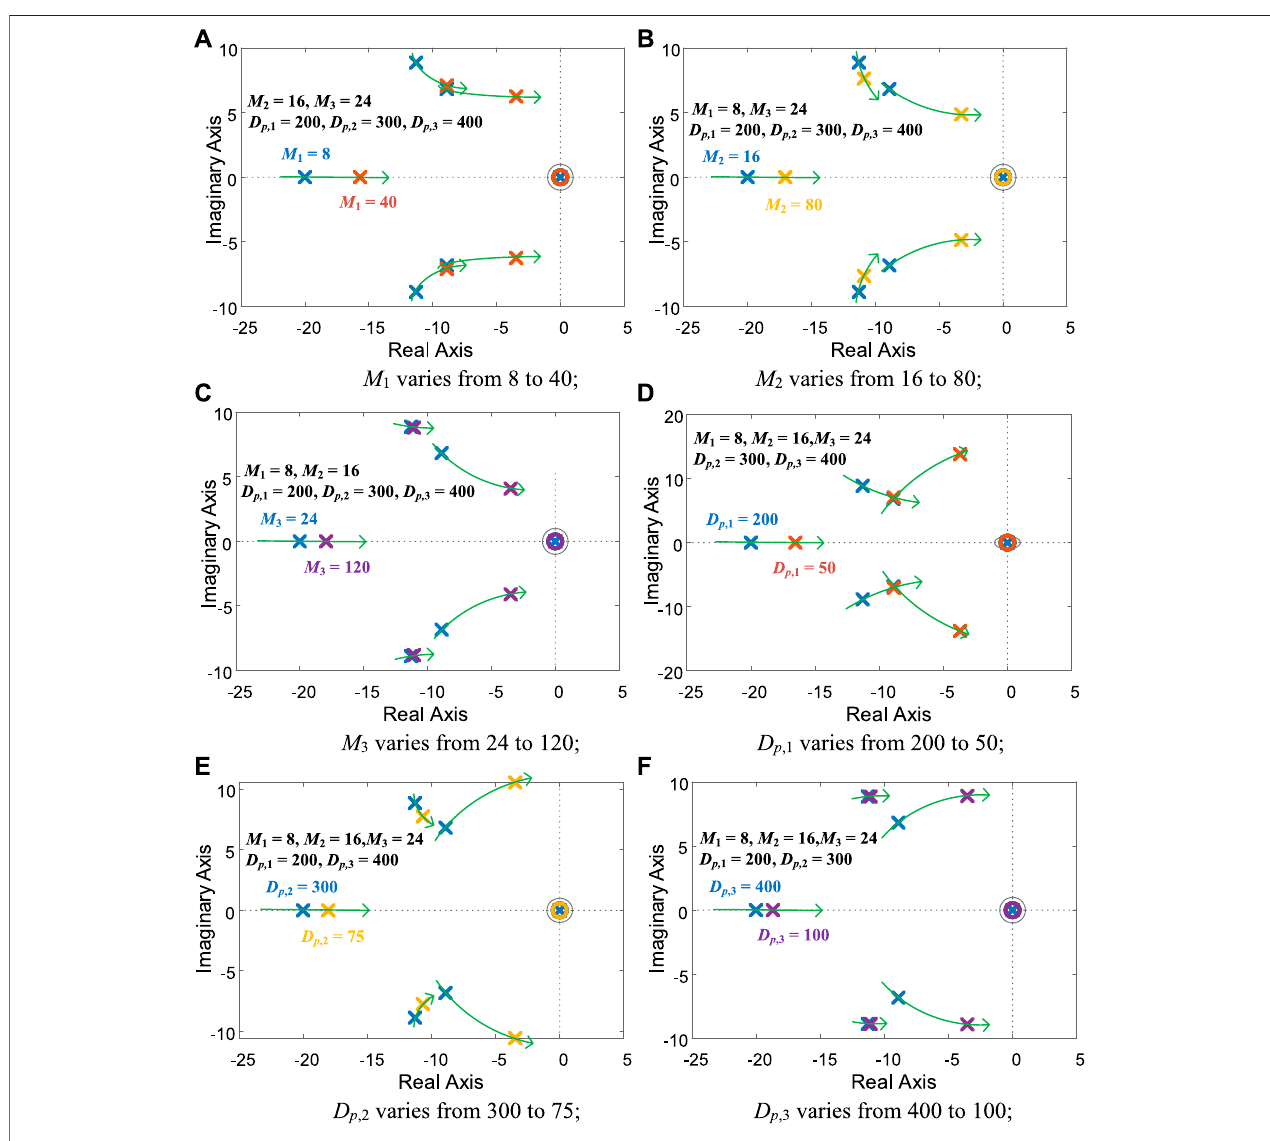
FIGURE 4 | Root locus of the system when the parameters